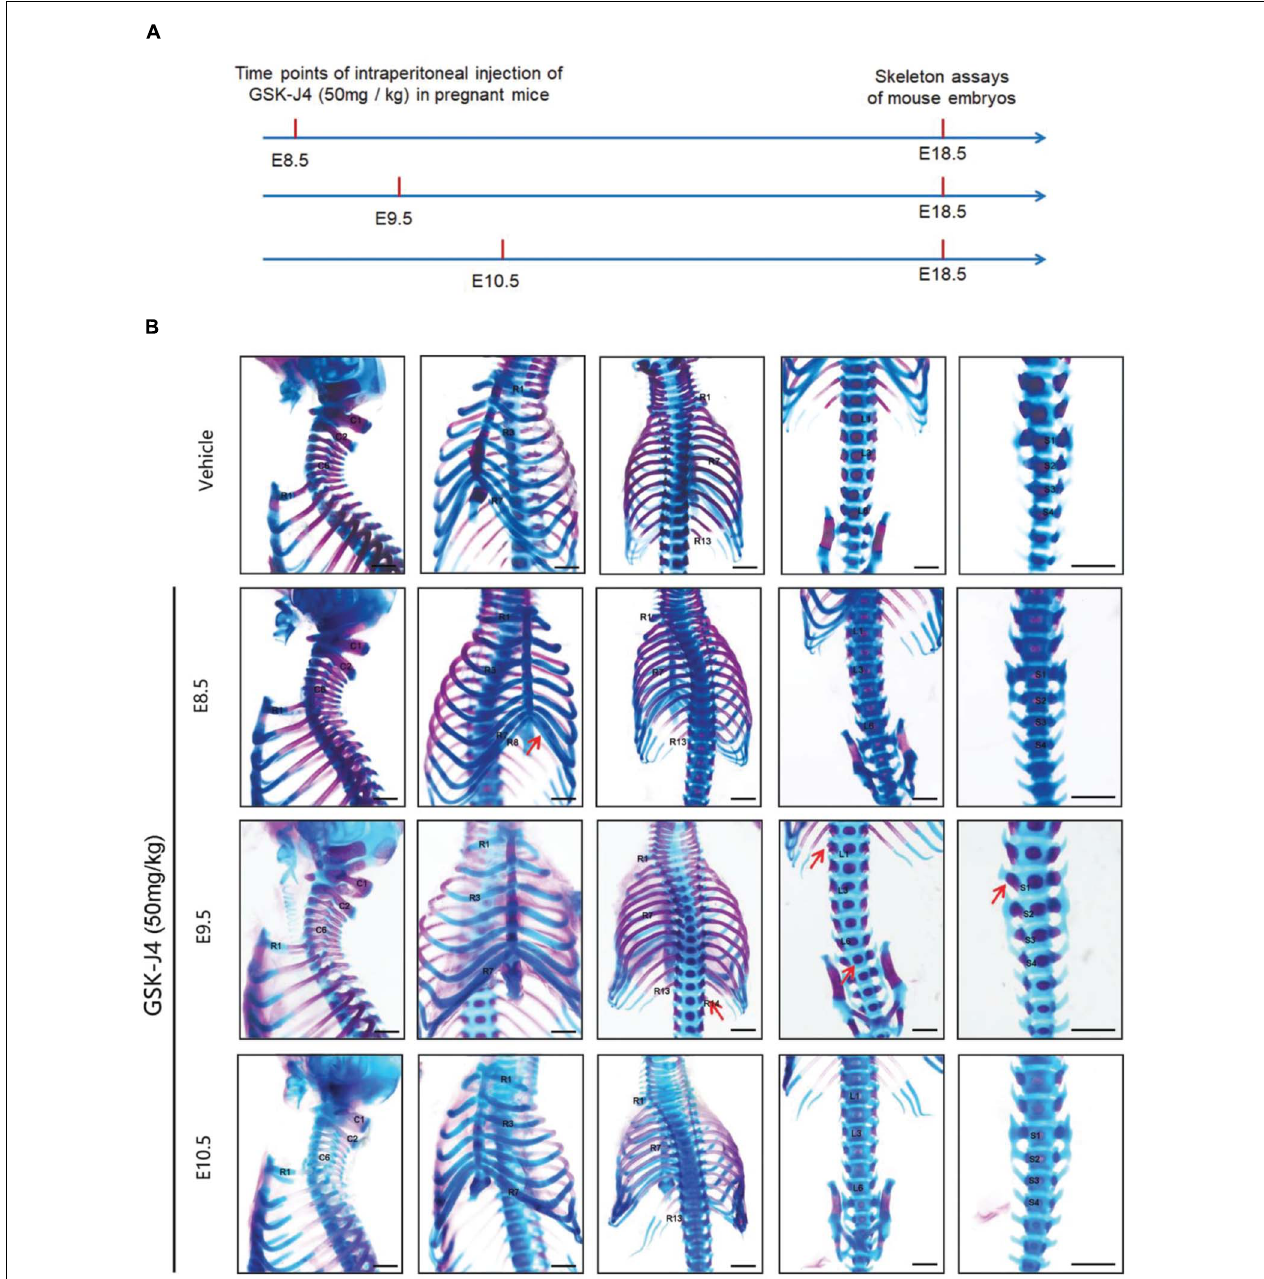
FIGURE 1 | Homeotic transformations by GSK-J4 treatment at the time points of E8.5, E9.5, or E10.5. (A) Experimental design for studying the roles of GSK-J4 on body axis patterning. (B) Embryos had been exposed to GSK-J4 at the time points of E8.5, E9.5, or E10.5 as indicated. Skeletal phenotypes were prepared by removing forelimbs and hindlimbs. The red arrow indicates homeotic transformations of axial skeleton induced by GSK-J4. Frequencies of homeotic transformations are given in Table 1 . The cervical (C), rib (R), lumbar (L), and sacral (S) vertebrae are numbered. For schematic explanation, see Supplementary Figure 9 . Scale bar, 1